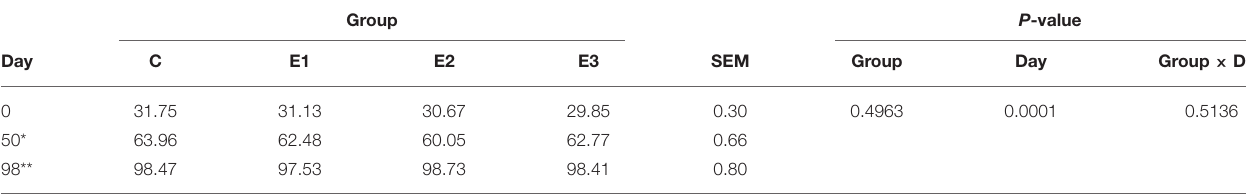
TABLE 4 | Average body weight (kg) of growing pigs fed different Se source and concentration with P -values of effects tested in statistical model. Group P -value E1 E2